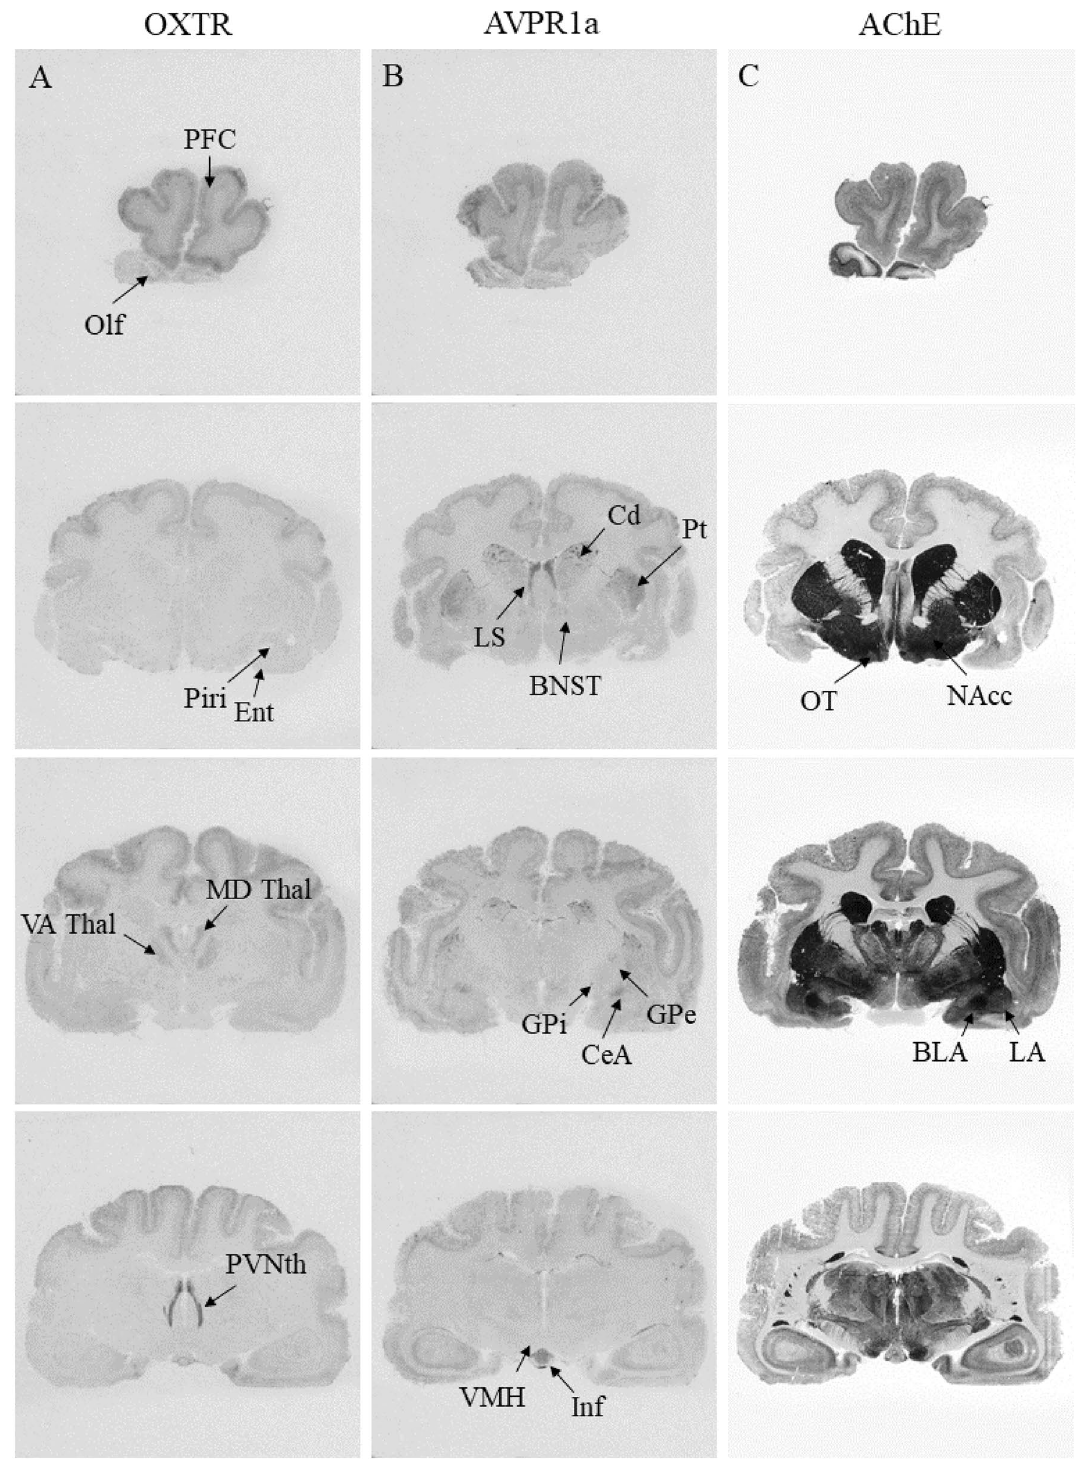
Figure 2. Distribution of OXTR ( A ) and AVPR1a ( B ) in sequential coronal sections from the brain of one representative non-monogamous Eulemur individual ( E. macaco) , aligned with acetylcholinesterase (AChE) counterstain ( C ). Panels